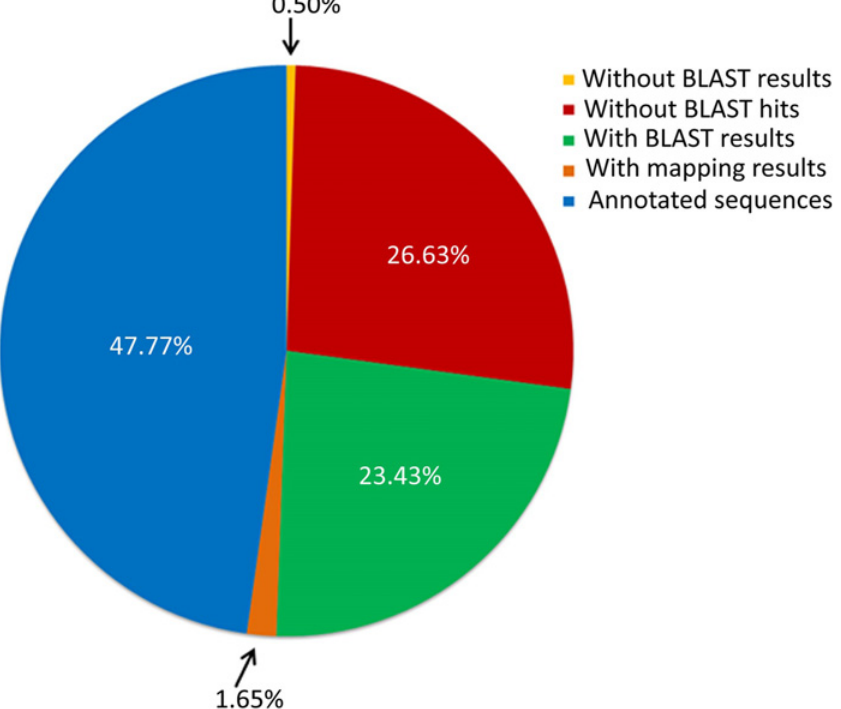
Fig 3. Summary of sequence annotation statistics from BLAST2GO. Representative sequences from all the 8,099 HGCs were subjected to annotation out of which 47.77% (3,869) sequences were annotated with GO slim terms, 26.63% (2,157) sequences were without any BLAST hits, 23.43% (1,898) sequences had only blast results but didn ’ t had annotation and 1.65% (134) sequences retrieved mapping results but were without GO slim terms. A small fraction of 0.5% (41) sequences failed to fetch BLAST results.